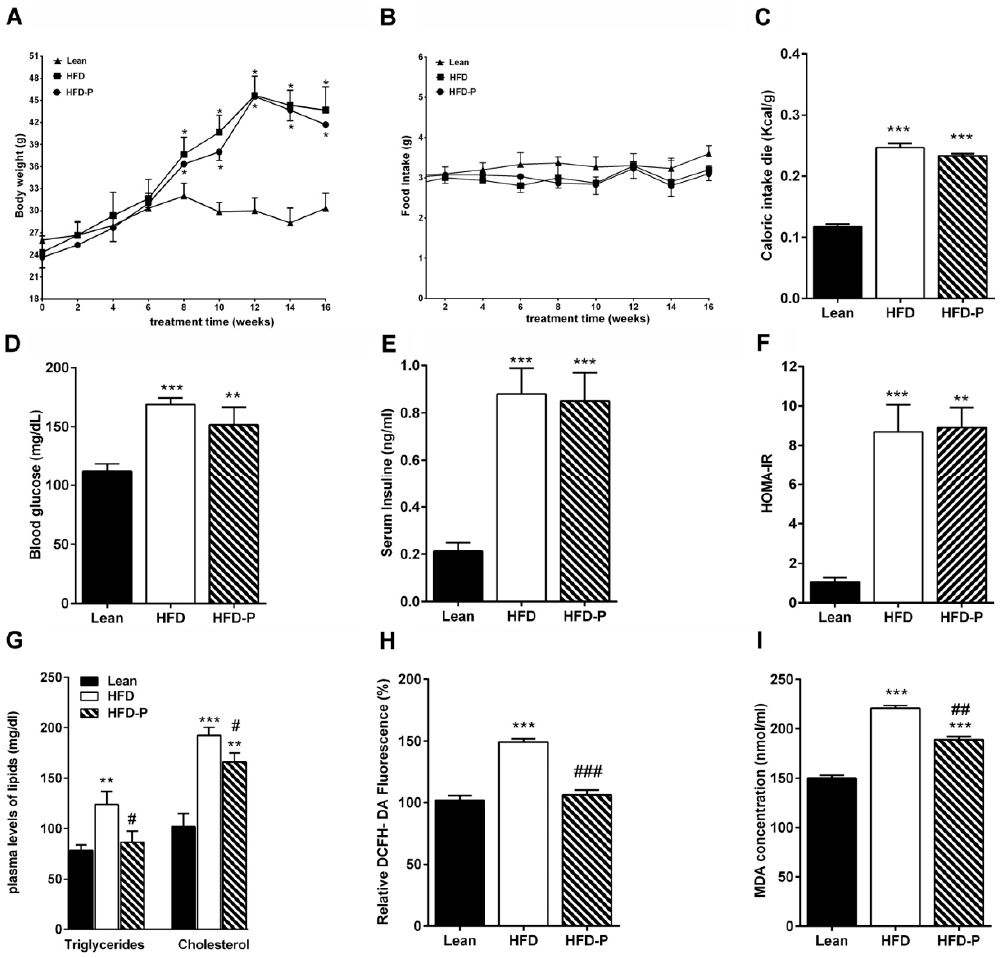
Figure 1. Pistachio consumption attenuates alterations of various metabolic and oxidative parameters in a high-fat diet (HFD) mice. Values in mice after 16 weeks of standard diet (STD), HFD or HFD supplemented with pistachio (HFD-P): ( A ) body weight; ( B ) daily food intake; ( C ) caloric intake; ( D ) fasting glucose concentration; ( E ) serum insulin concentration; ( F ) HOMA-IR; ( G ) plasma levels of triglycerides and cholesterol; ( H ) plasma ROS levels in lean, HFD, or HFD-P mice expressed as % of lean; ( I ) plasma lipid peroxidation levels in the di ff erent animal groups. Data are means ± standard error medium (SEM) ( n = 8 / group). * p < 0.05, ** p < 0.01, *** p < 0.001 vs STD. # p < 0.05, ## p < 0.01, ### p < 0.001 vs HFD.